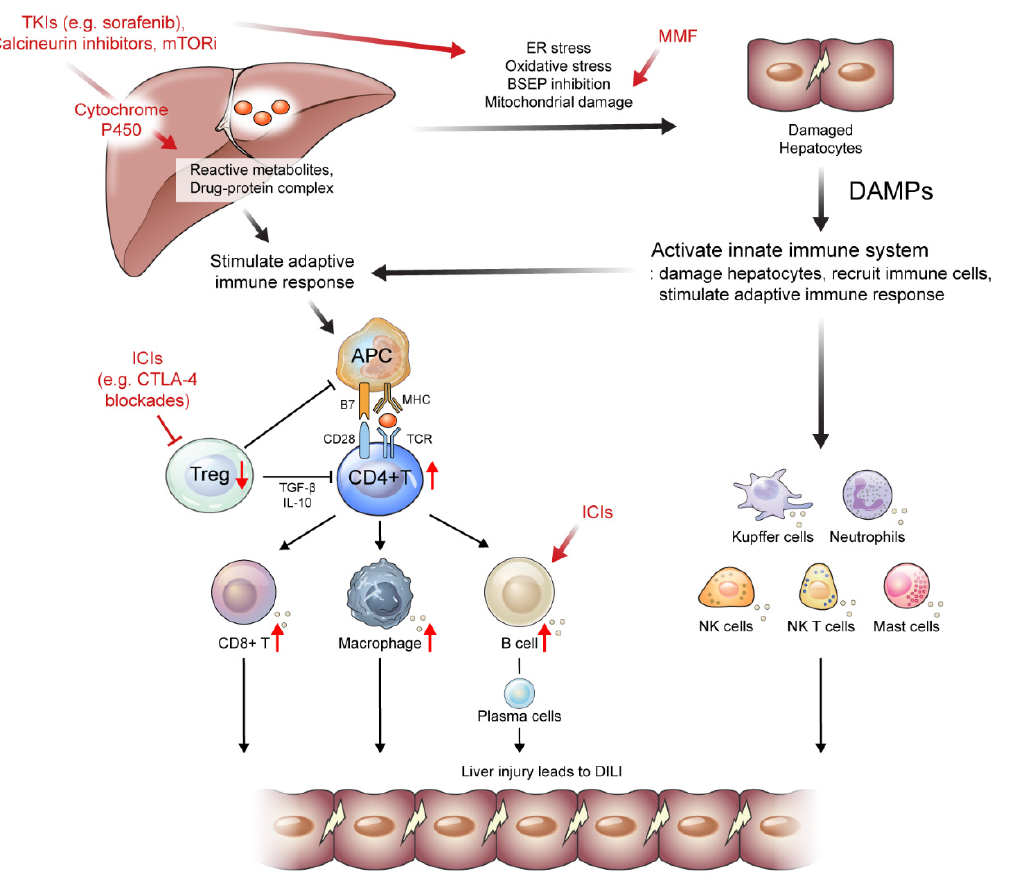
Figure 2. Suggested mechanisms of drug-induced liver injury (DILI) caused by drugs administered to patients with hepatocellular carcinoma or liver transplantation. Several tyrosine kinase inhibitors (TKIs), calcineurin inhibitors, and mTOR inhibitors are metabolized via the cytochrome P450 pathway, which may be associated with the production of a toxic intermediate. These drugs can also induce oxidative stress and apoptotic pathway activations, which can lead to the activation of immune response. Mycophenolate mofetil can induce mitochondrial damage, which then leads to DILI. Immune checkpoint inhibitors (ICIs) deplete Treg cells inducing the reduction of anti-inflammatory cytokines and proliferation of CD8 + T cells. Moreover, early B cell changes may induce autoreactive B cells, leading to ICI-induced DILI. APC, antigen presenting cells; BSEP, bile salt export pump; DAMP, damage-associated molecular patterns; ER, endoplasmic reticulum; ICIs, immune checkpoint inhibitors; MMF, mycophenolate mofetil; mTORi, mammalian target of rapamycin inhibitors; NK, natural killer; TKI, tyrosine kinase inhibitors; Treg, regulatory T cells; ↑ , an increase in the indicated cells; ↓ , a decrease in the indicated cells; ┤ , the reduction and depletion of indicated cells.